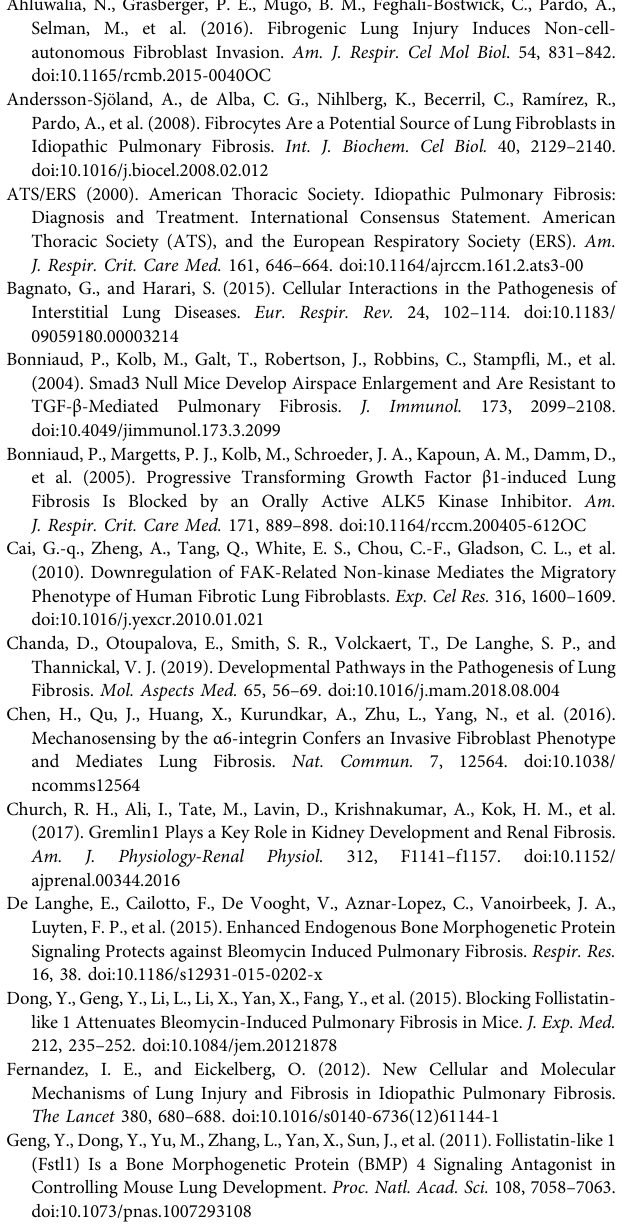
group, *** p < 0.001. Unpaired student t test. (E) Detection of the p-Smad1 and p-Smad2 in the fi broblasts from PBS or bleomycin treatment group, Smad1 and Smad2wereusedastheoverallcontrolgroup.CTR n (cid:2) 3,BLM n (cid:2) 3.Pairedstudent t test was used, p (cid:2) 0.0011. (F) Expression level of p-Smad1 in the fi broblasts from PBS or bleomycin treatment group using immuno fl uorescence. Green represents p-Smad1 and p-Smad2, and blue represents DAPI (nucleus). Scale bar (cid:2) 10 μ m. CTR n (cid:2) 3, BLM n (cid:2) 5. Scale bar (cid:2) 10 μ m. (G) Expression level of p-Smad2 in the fi broblasts from PBS or bleomycin treatment group using immuno fl uorescence. Green represents p-Smad1 and p-Smad2, and blue represents DAPI (nucleus). Scale bar (cid:2) 10 μ m. CTR n (cid:2) 3, BLM n (cid:2) 5. Scale bar (cid:2) 10 μ m. CTR presented as PBS treatment group, BLM presented as the bleomycin treatment